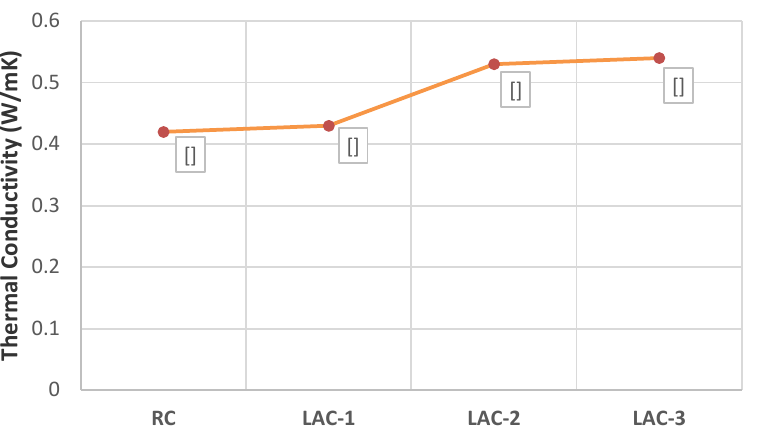
Figure 13. Thermal conductivity of the mixes.